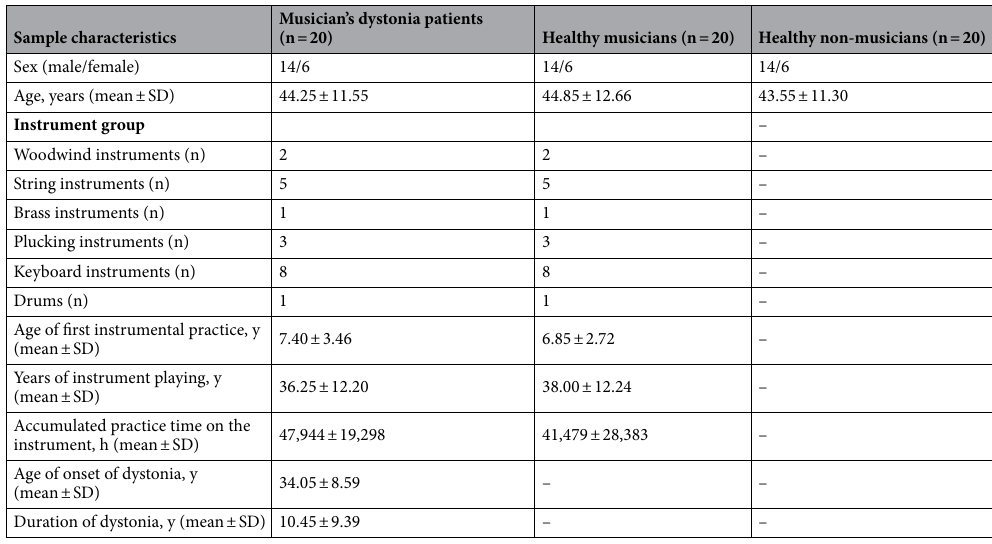
Table 1. Characteristics of patients and controls. y years, h hours, SD standard